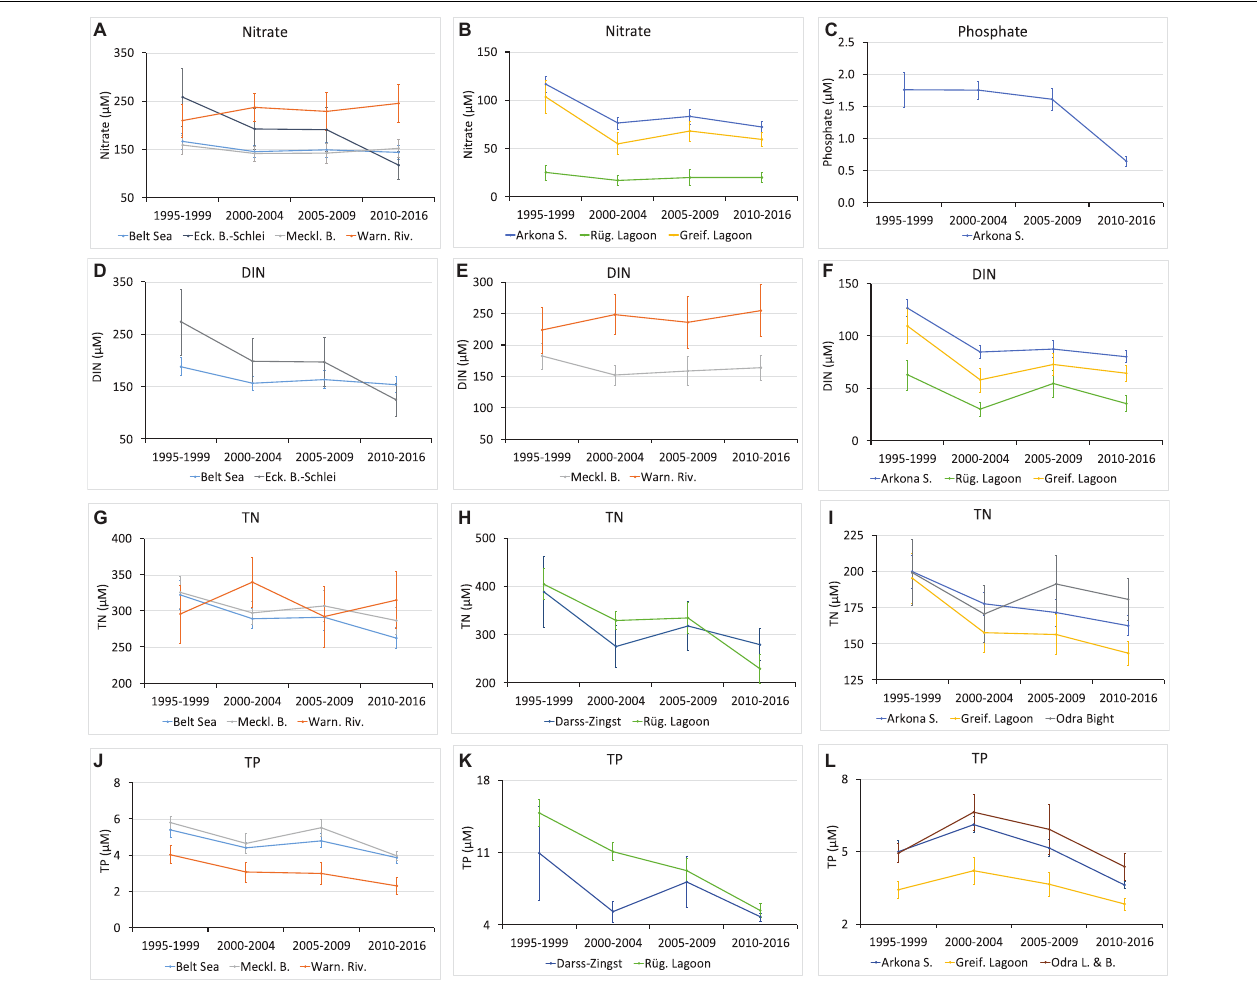
FIGURE 4 | Freshwater end-member concentrations of the investigated nutrients, nitrate (A,B) , phosphate (C) , DIN (D–F) , TN (G–I) , and TP (J–L) versus the time periods from significant regression lines ( > 99%); the upper andlower boundaries of the 95% confidence interval are given as error bars (see Table 1 ).